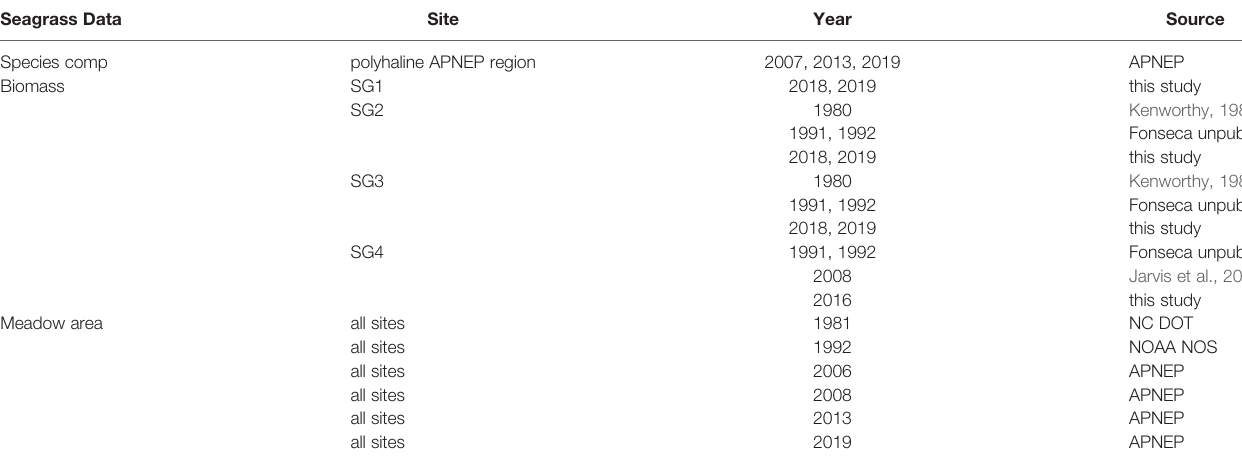
TABLE 1 | Data sources and years of collection for all seagrass measurements at each